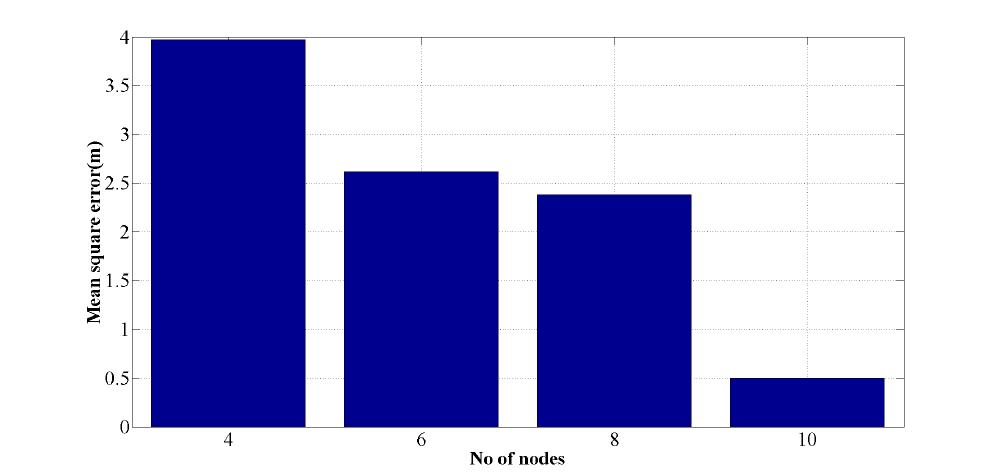
Figure 6. Number of nodes vs. mean square error (m).